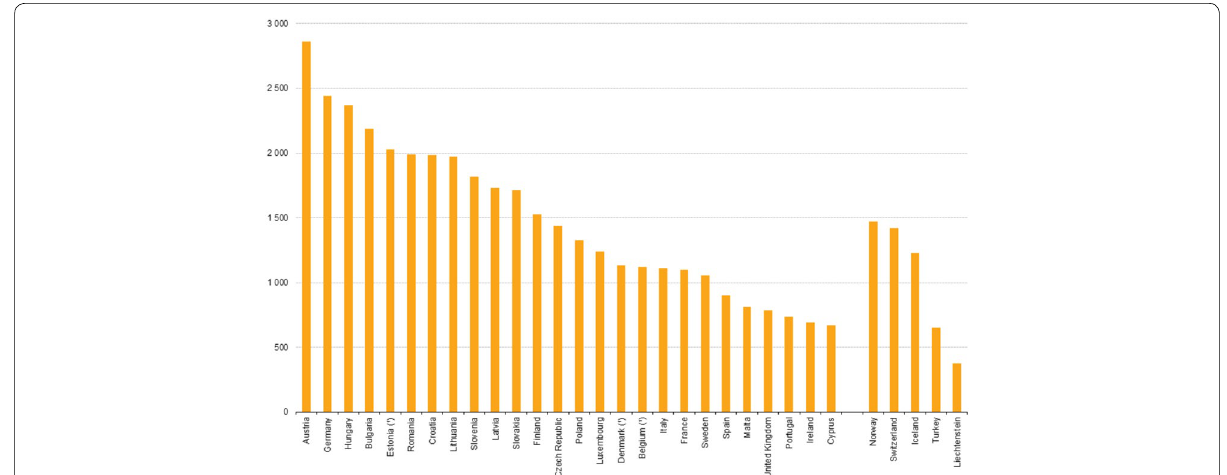
Fig. 2 Hospital discharge rates for in‑patients with neoplasms, 2014 (per 100,000 inhabitants). Note the substantial variation between different European countries (source: